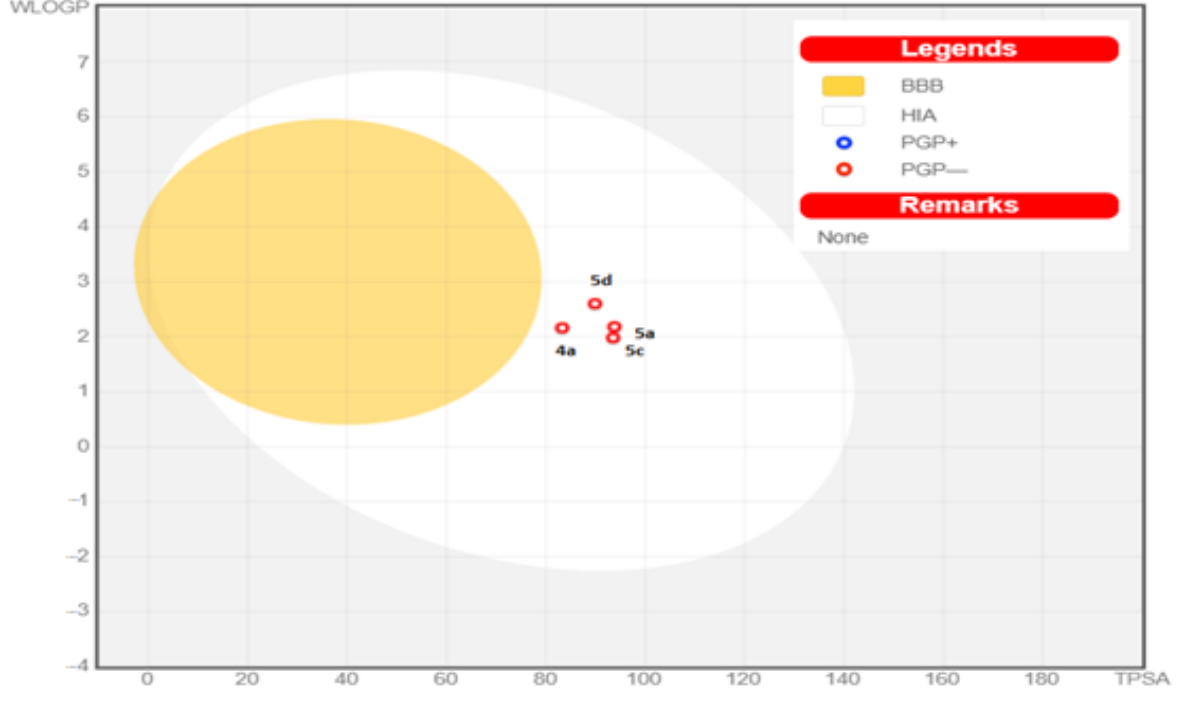
Figure 7. Boiled-egg chart illustrating the pharmacokinetic properties of the promising new quinazolin-4(3 H )one derivatives.